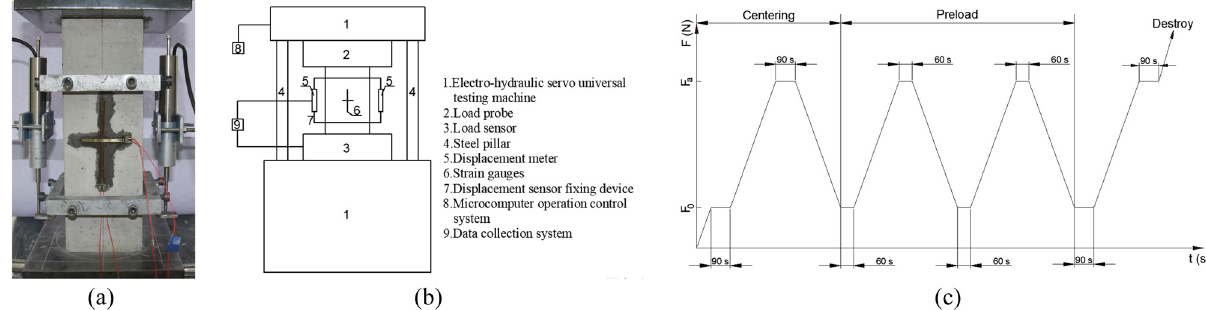
Figure 6: Diagram of an axial compression test: ( a ) actual loading diagram, ( b ) instrument layout diagram, and ( c ) loading diagram.